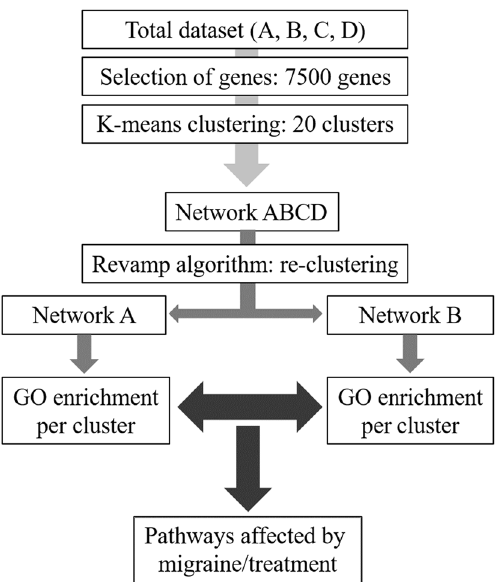
Figure 2. Workflow of differential gene regulatory network analysis, where the different time points are represented by ( A ) during attack, ( B ) after treatment, ( C ) headache-free, ( D ) after cold-pressor